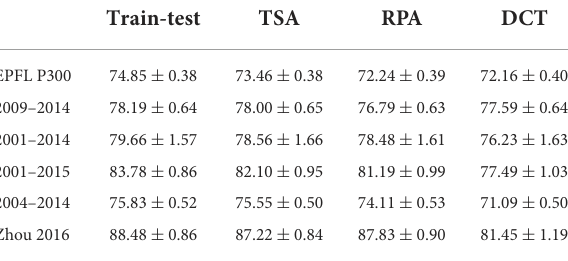
TABLE 7 Inter-session balanced accuracy table for each dataset and